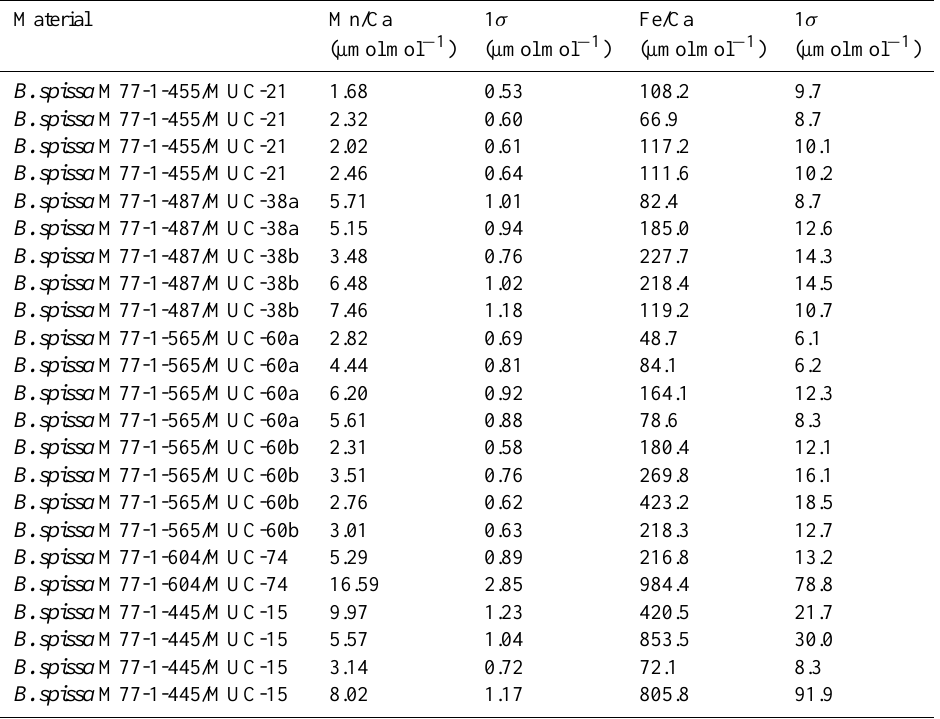
Table 3. Element/Ca ratios of foraminiferal calcite determined by SIMS.